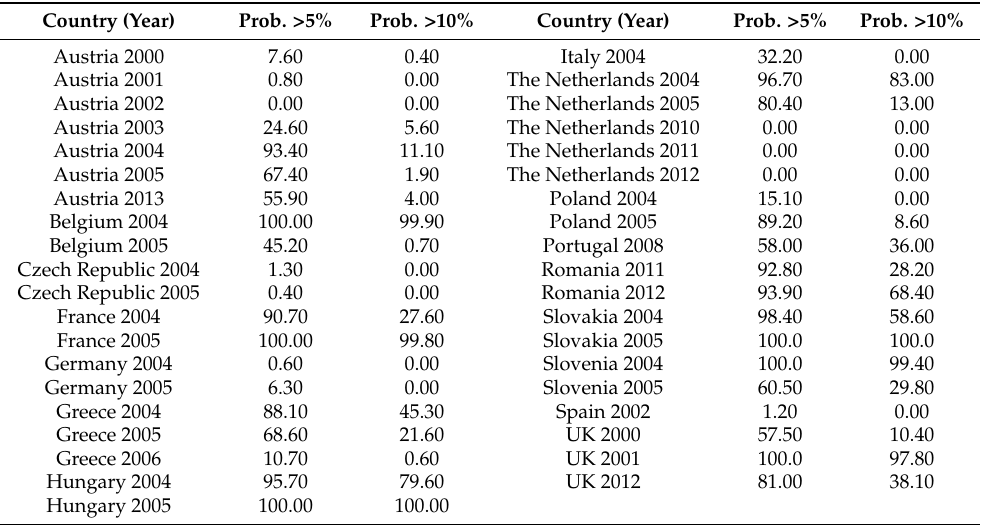
Table 3. Probability of rate of intercepting non-compliant feed products being above 5% and 10% per country and